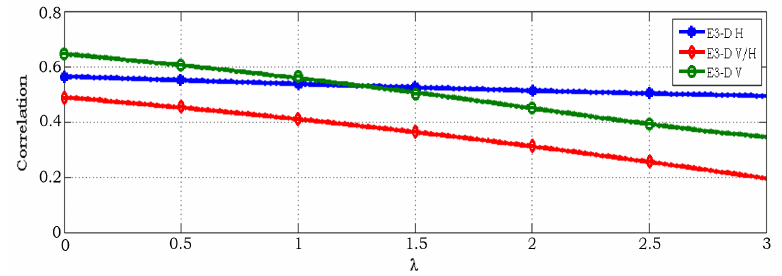
Figure 7. Correlation versus receiving antenna spacing on the beam pattern.